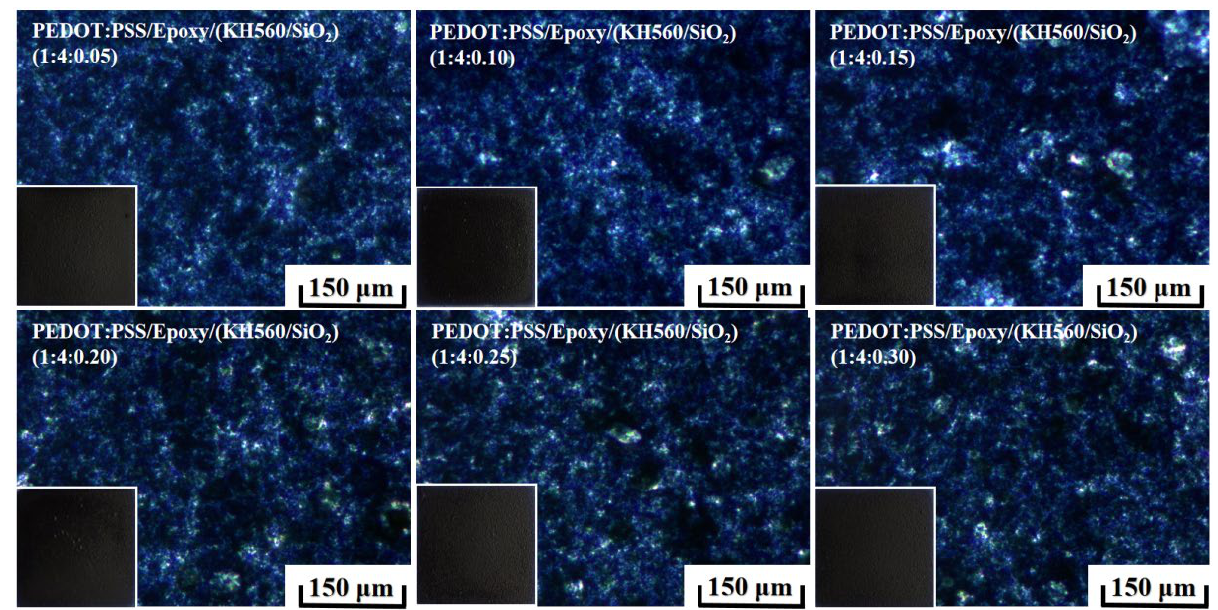
Figure 6. Microscope morphology photos of PEDOT:PSS/epoxy/(KH560/SiO 2 ) coatings (bottom light source) with different P:E:K ratios and their sample images.